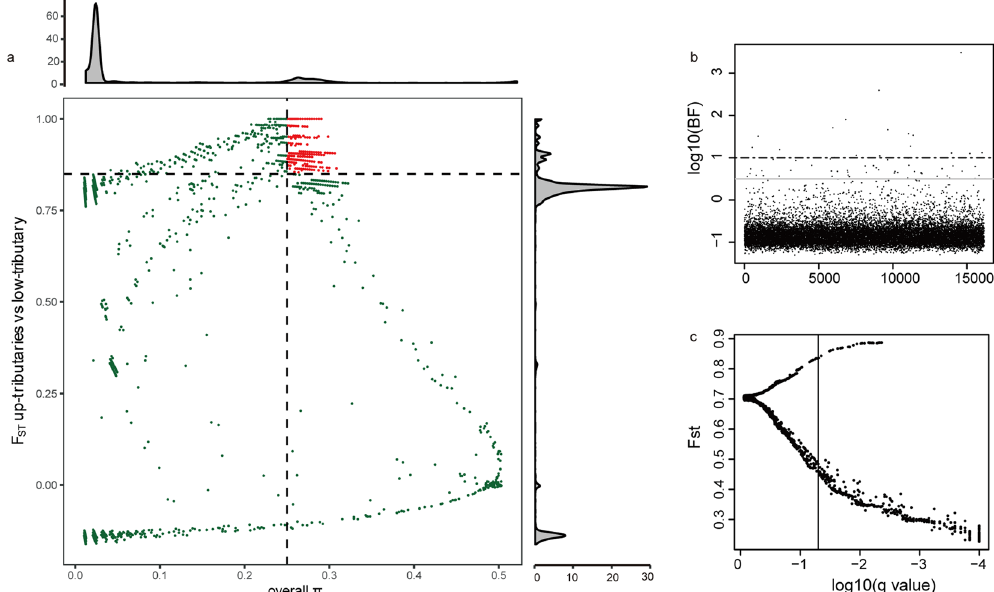
Figure 3. Outliers detection among tributaries. ( a ) Distribution of F ST and overall π values of dataset 4 (8,621 SNPs dataset). Data points on the right of the vertical dashed line (corresponding to the 5% left tail of the empirical π distribution), and above the horizontal dashed line (5% right tail of the empirical F ST distribution) were identified as selected regions for up tributaries and low tributaries (red points), and points represented by “ + ” are significant values. ( b ) Manhattan plot of genetic differentiation associated with altitude using dataset 2 (7,125 SNPs loci). Grey solid lines indicate lower thresholds of log 10 (BF) = 0.5 and black dashed lines indicate higher thresholds of log 10 (BF) = 1. ( c ) Global outlier detection among dataset3 (12,125 SNPs loci) in 6 C. macropterus populations (UT, MT and LT) from the Nujiang River. The vertical line represents a false discovery threshold of